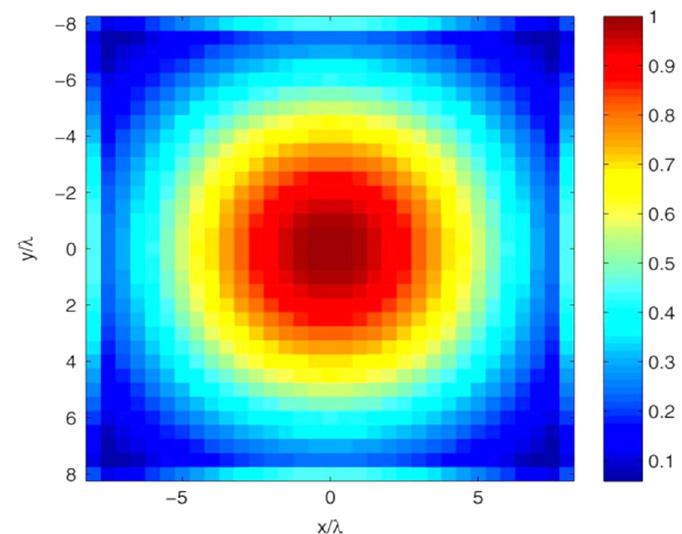
Figure 10. Excitation field of reference array.